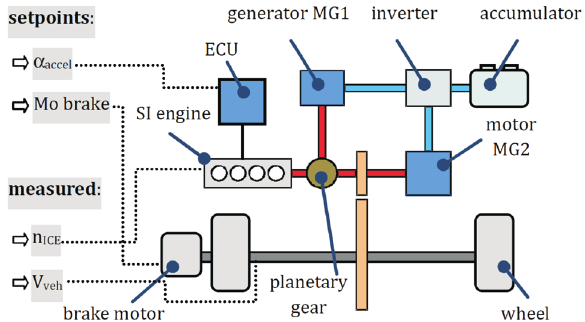
Fig. 2. The diagram of the test stand for determining the parameters of a combustion engine operation and a vehicle with hybrid drive system Rys. 2. Schemat stanowiska do wyznaczania parametrów pracy silnika spalinowego i pojazdu z układem napędu